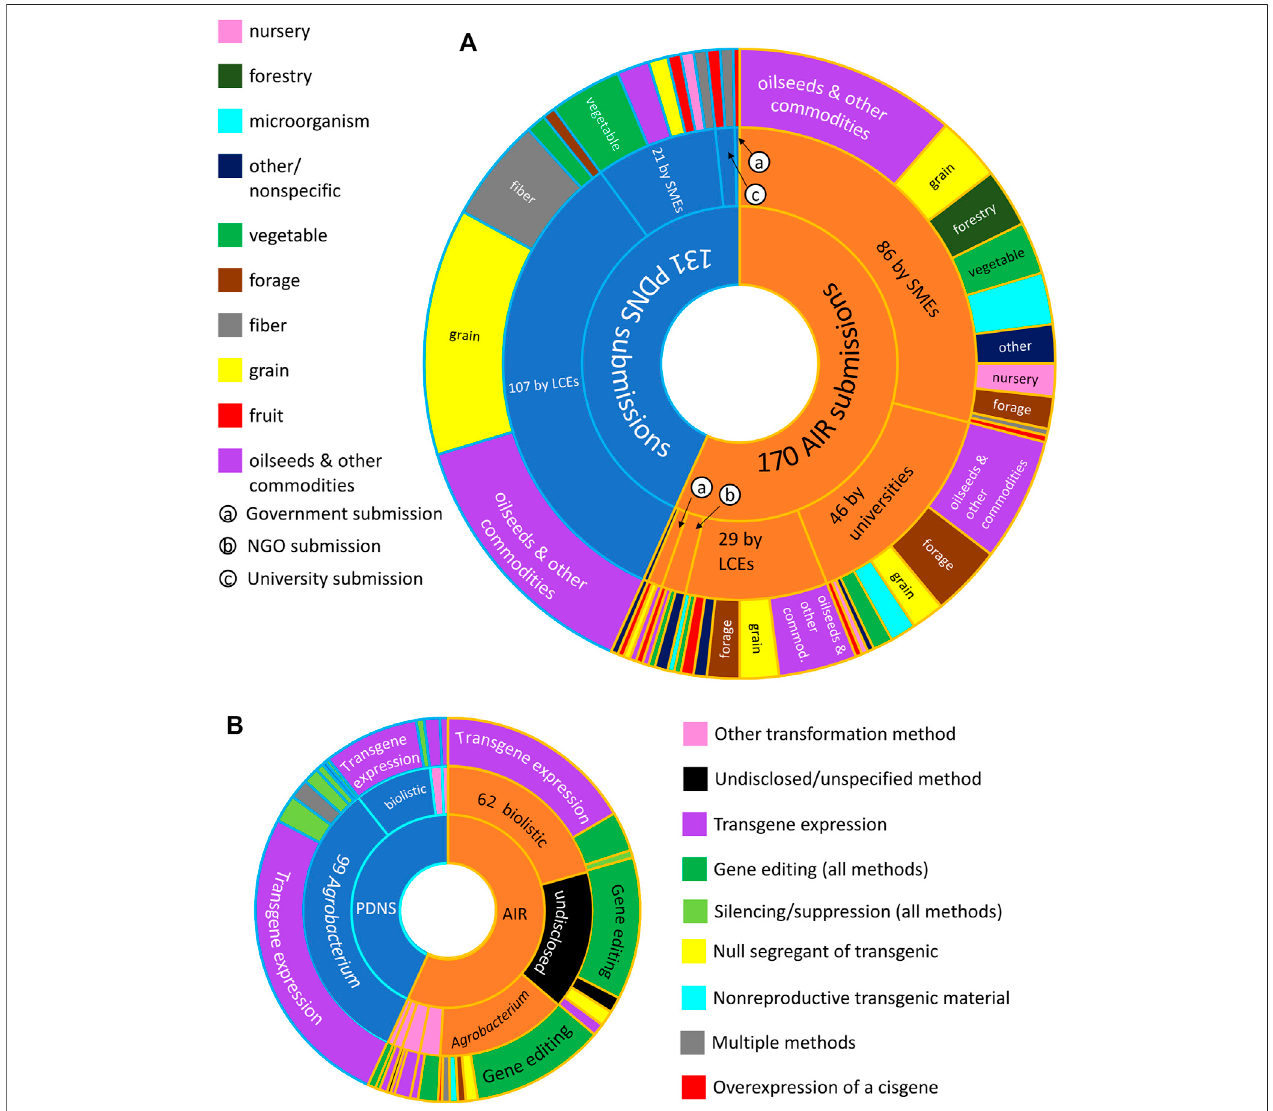
FIGURE1| OverviewofdifferentfactsofdiversityacrossAIRandPDNS. (A) Totalsubmissions (innermostring)andnumberofsubmissionscontributed fromeach category of developer (center ring). The outermost ring shows the number of submissions in each crop category submitted by each category of developer. (B) Total submissions (innermost ring), transformation methods (center ring), and engineering methods (outermost ring) used in submissions to each regulatory pathway. Submissions containing undisclosed/redacted transformation methods (center ring) or engineering methods (outer ring) are shown in black.